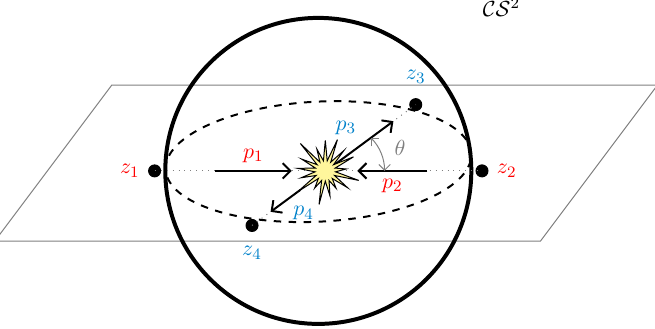
Figure 1 . Kinematic constraints on massless 12 → 34 scattering as viewed from the celestial sphere. Because of momentum conservation, the scattering process can be embedded in a three-dimensional surface. If we look at how this surface intersects the celestial sphere, we find that there are non-trivial constraints on the operator